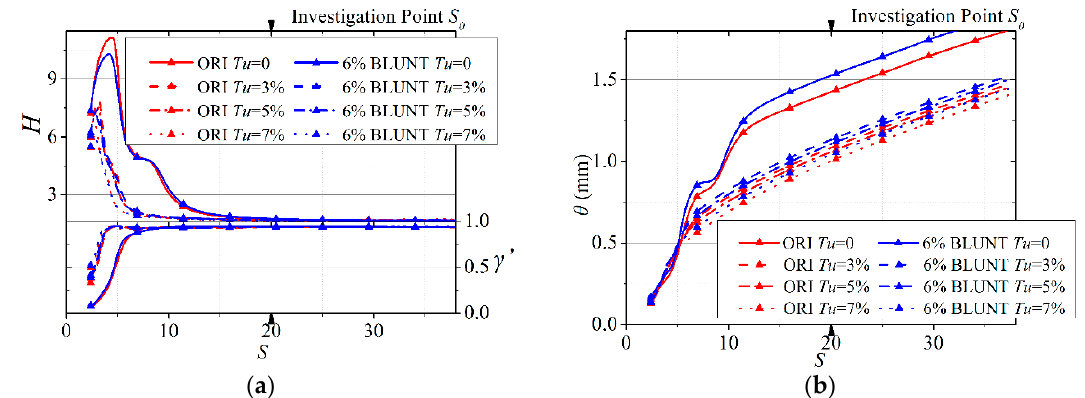
Figure 13. The 6% BLUNT of Ellip.LE at Tu = 5%, i = 2 deg: ( a ) the boundary layer momentum thickness and normal average turbulence intermittency; ( b ) Shape factor along aerofoils.